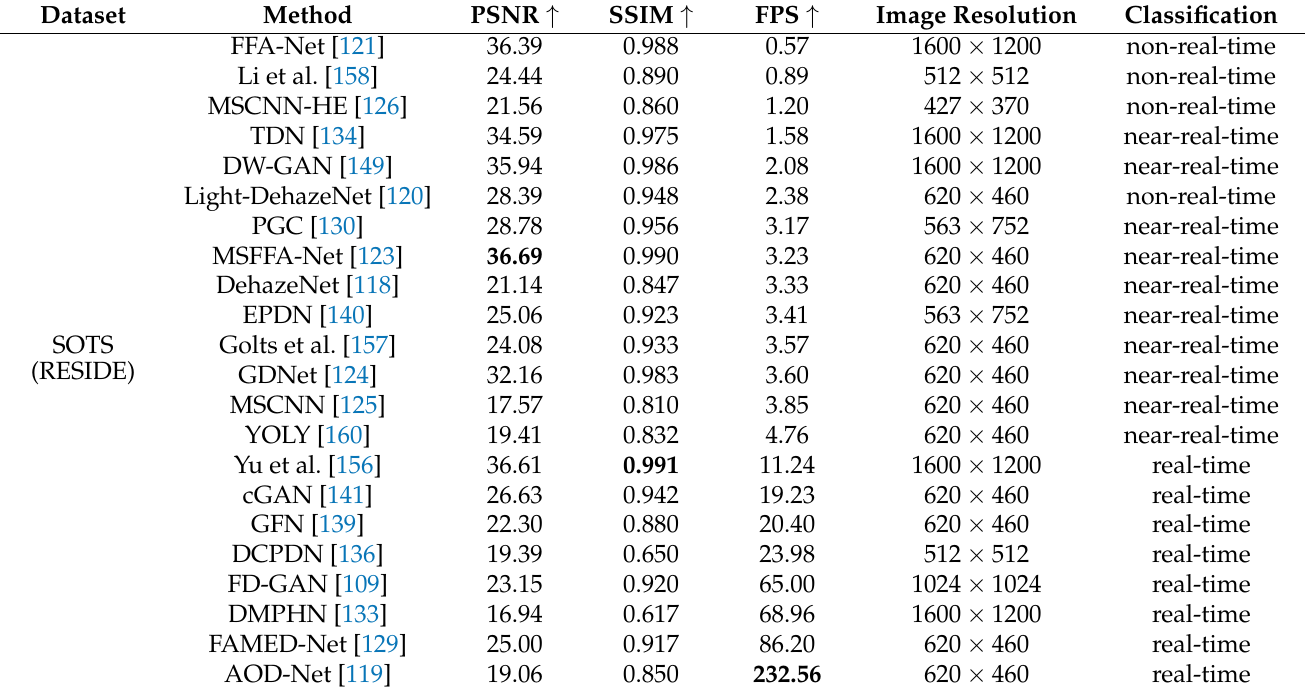
Table 9. Quantitative results of dehazing methods along with their running time. ↑ means higher is better. In bold we indicate the best result among the evaluated